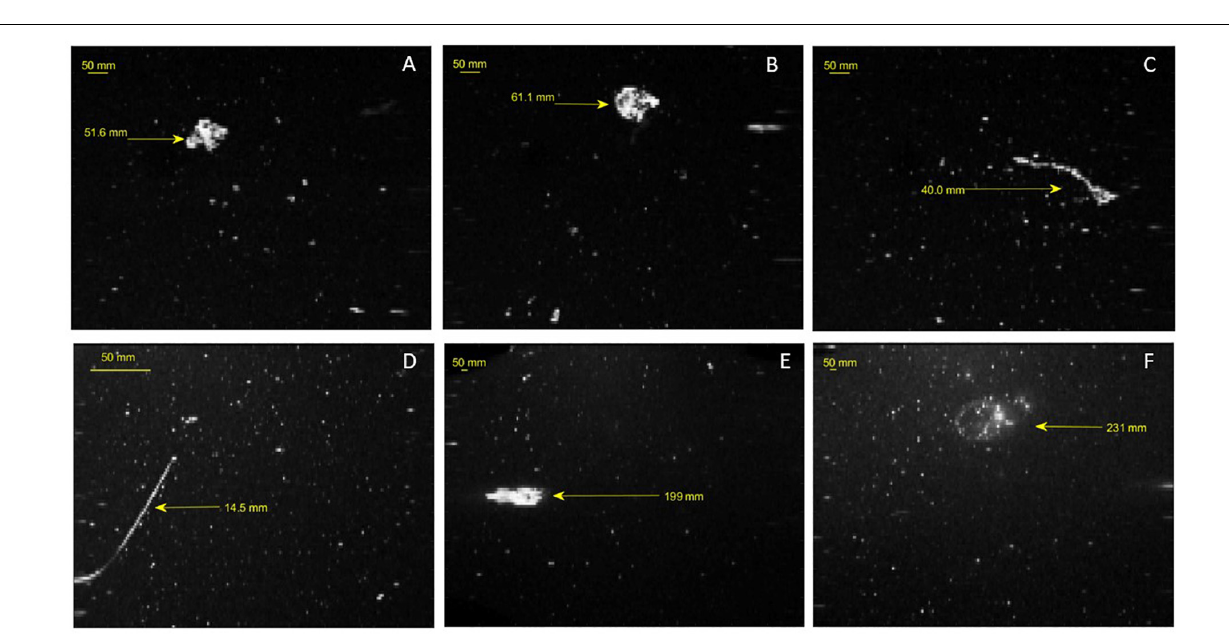
deviation ( σ p ) to allow for an unbiased description of particle proximity when calculating the z-score. Figure 8 provides a comparison of the particle spatial distribution of an image from the dawn station with a simulated uniform distribution. The z -score for the sample image ( Figure 8A ) was calculated as − 0.53, indicating agreement with uniformly distributed particles.